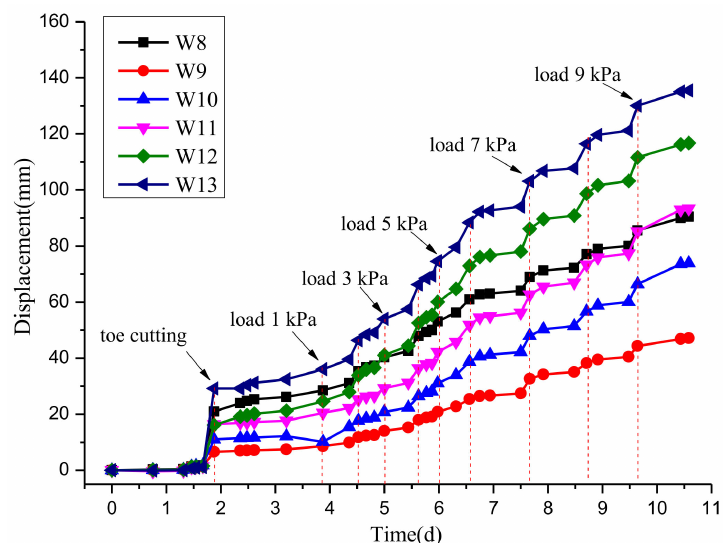
Figure 17. Vertical displacement variation curve of the top of the slope.